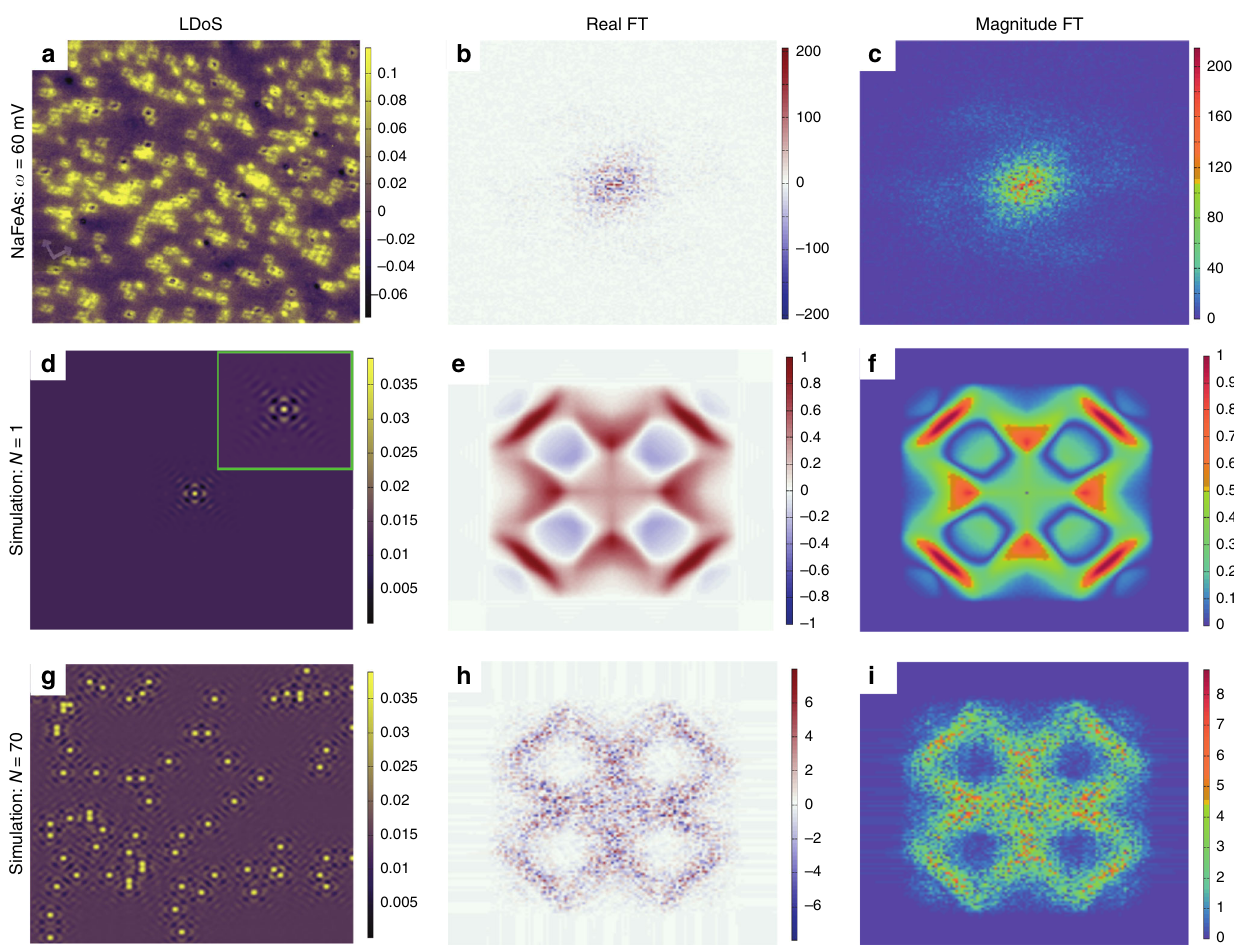
Fig. 1 Shortcomings of the Fourier transform analysis. a The experimentally obtained LDoS of NaFeAs over a 100 × 100 nm 2 area of the sample at energy ω = 60 mV from ref. 18 with junction conditions V = − 100 mV and I = 300 pA measured at T = 26 K. Color bar units are nS. b , c Real part and magnitude, respectively, of the FT of a showing large phase noise. Color bar units are nS − 1 . d Simulated image of scattering from a single point defect. e , f Real part and magnitude, respectively, of the FT of d . The LDoS scale in d was chosen such that the FT magnitude for the simulated single defect had a maximum of 1. g – i Corresponding simulated LDoS and FTs for scattering from 70 point defects that are randomly distributed in space. The color bars for d – i are in arbitrary units. All FT spectra are shown for − 3 π /5 a ≤ q x , q y ≤ 3 π /5 a . Comparison with the single defect case shows that noise in the FTs arises from the random placement of defects. Furthermore, the maximum amplitude of the FT scales approximately as